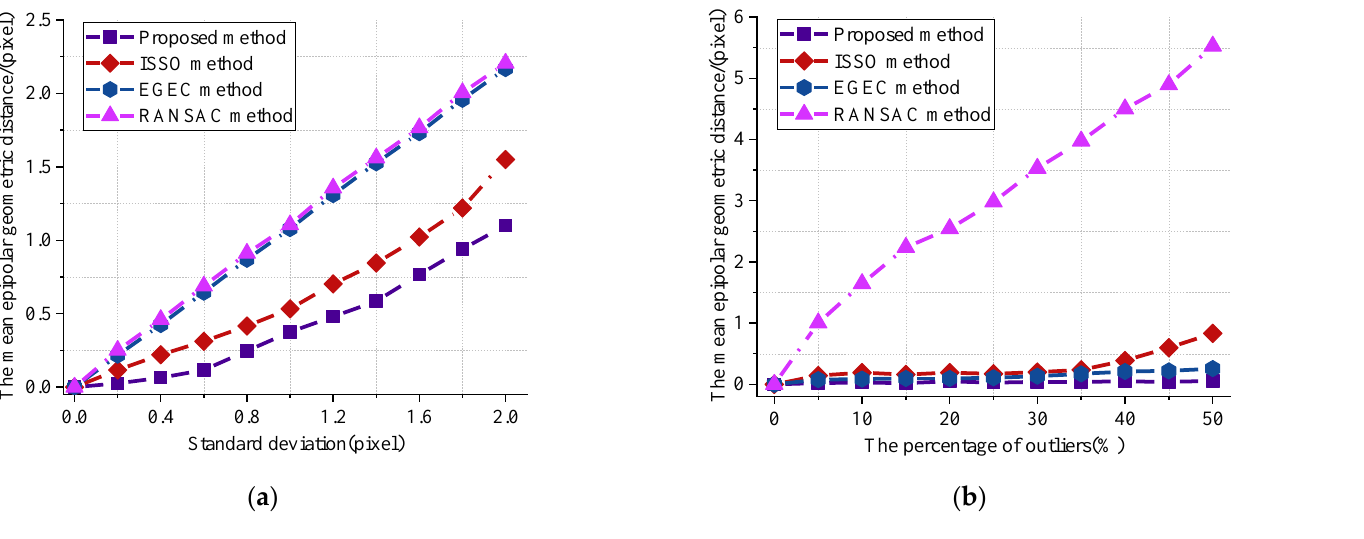
Figure 5. Comparisons of the epipolar geometric distances. ( a ) The mean geometric distance with varying Gaussian noise; ( b ) The mean geometric distance with varying outliers proportion.